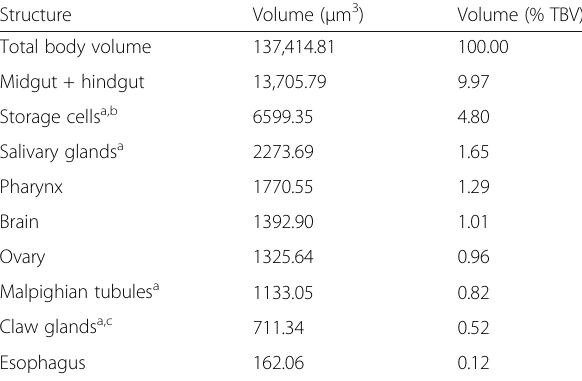
Table 1 Volumes of the segmented structures given in cubic micrometers and as a percentage of the total body volume (TBV) Structure